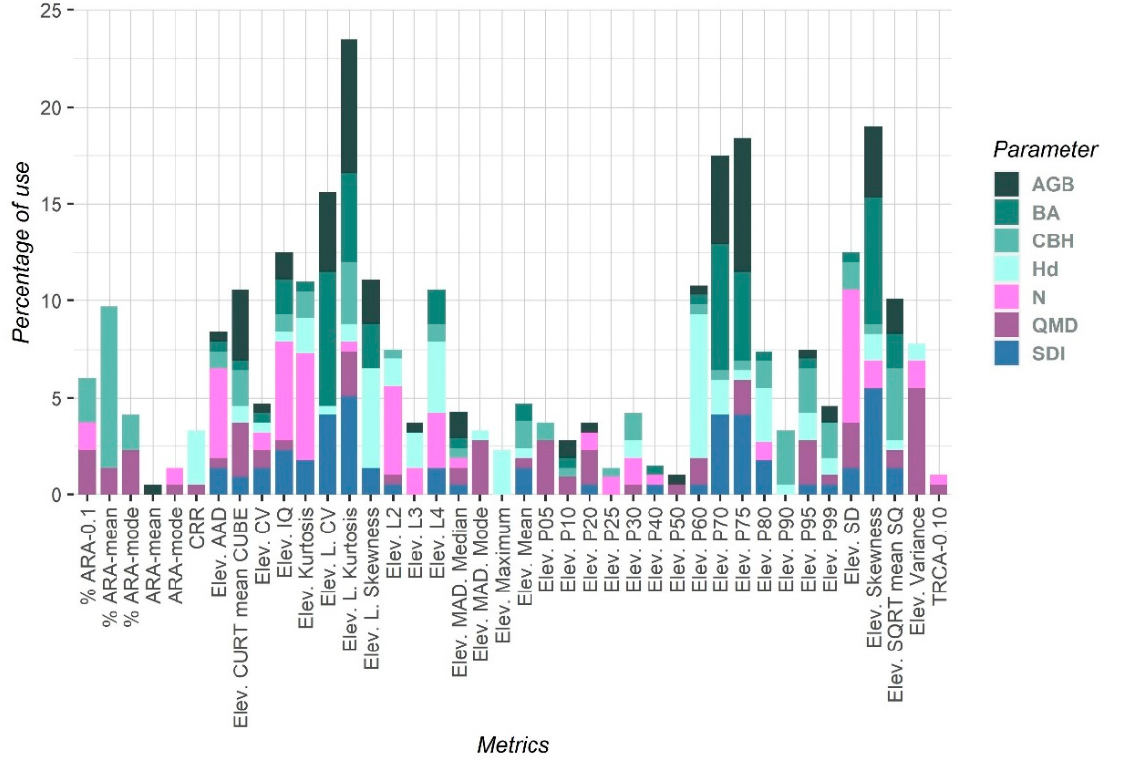
Figure 5. Percentage of use of LiDAR metrics in the generation of the predictive models for the seven forest parameters tested.